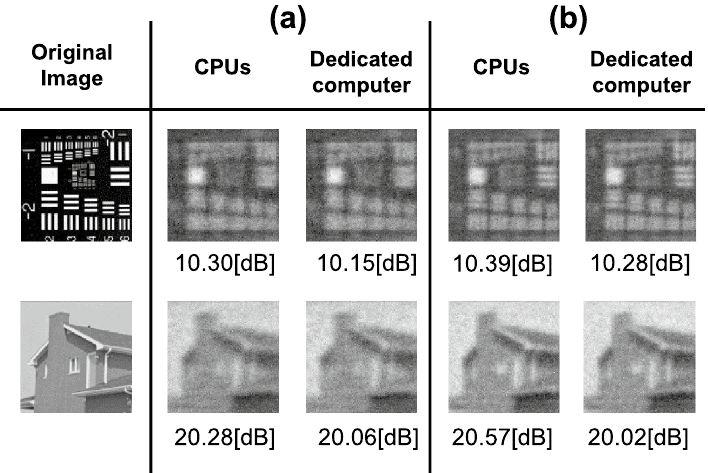
Figure 3. Simulation results of the desktop, embedded CPUs, and the dedicated computer. The size of the images is 128 × 128 pixels. We used single-precision floating-point operations on the CPUs and fixed-point operations on the dedicated computer. The number of the encoding mask patterns used in the reconstruction is 512 for ( a ) and 1024 for ( b ).